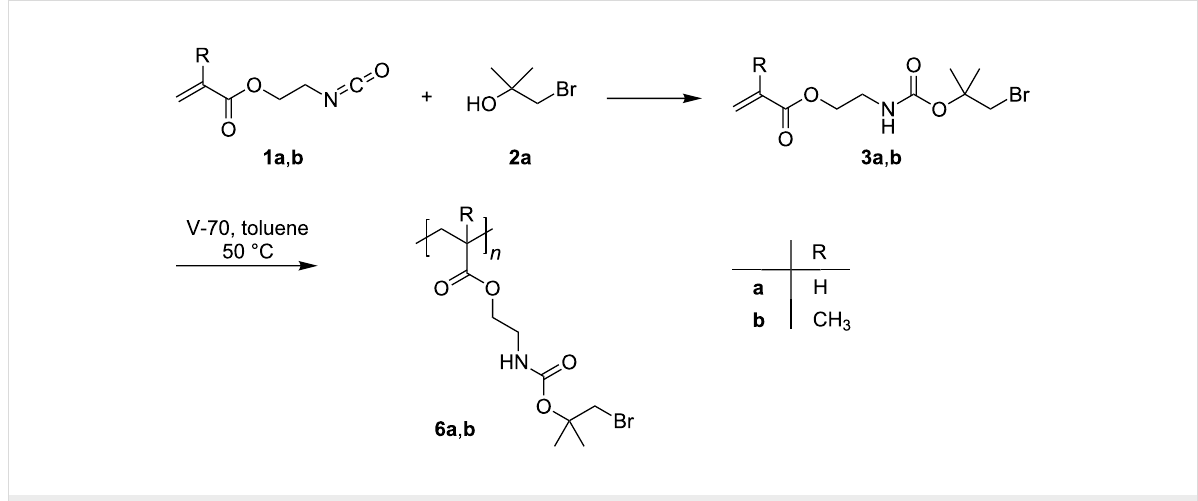
Scheme 1: Synthesis of Br- t -Boc-protected monomers 3a , b and homopolymers 6a , b .